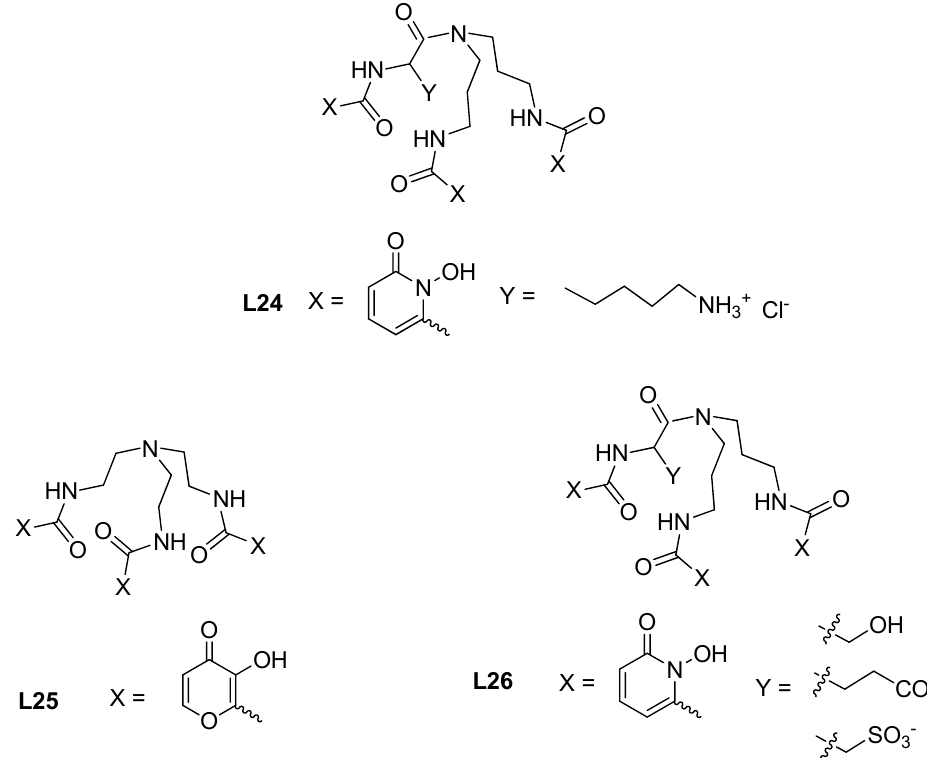
Figure 7. Molecular structure of selected hexadentate compounds for recognition and removal of anions from water